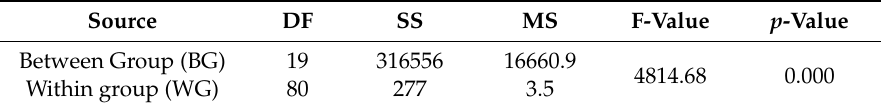
Table 6. The ANOVA test results of flexural strength.